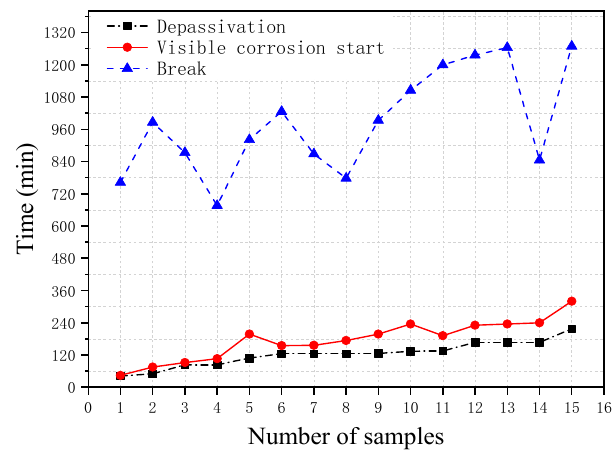
Figure 6. Depassivation time, corrosion starting time, and wire break time obtained from 15 corrosion tests ( F = 42 N, 7-day passivation, Cl − = 0.025 mol/L, pH = 10.3).